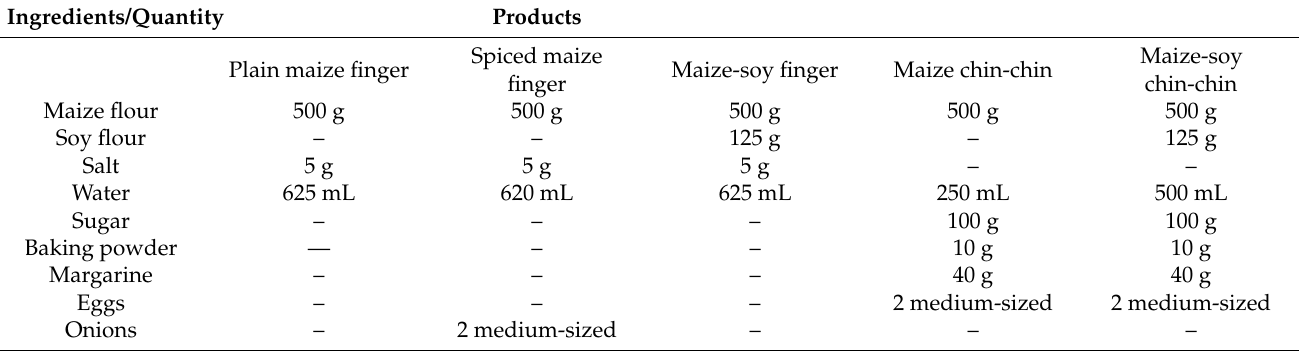
Table 1. Recipe for maize-based